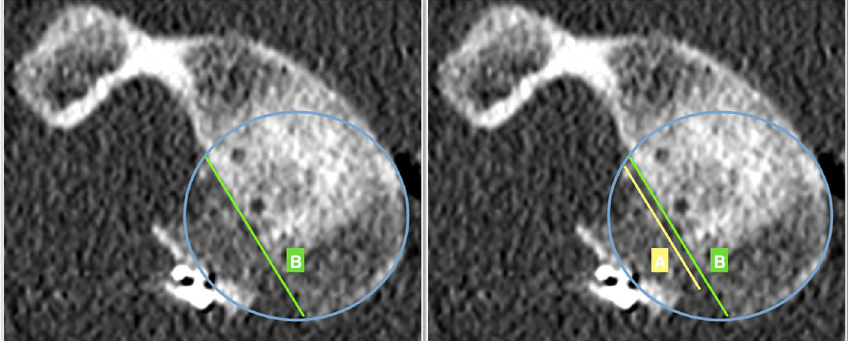
Fig. 2 a postoperative CT en-face image of the left shoulder of a subject with anterior shoulder instability following an arthroscopic bone block procedure. The bone-block position is evaluated using the “Defect coverage index method”. First the length of the bone defect is measured (green line, B) (A). Secondly, the amount of graft covering the glenoid defect is